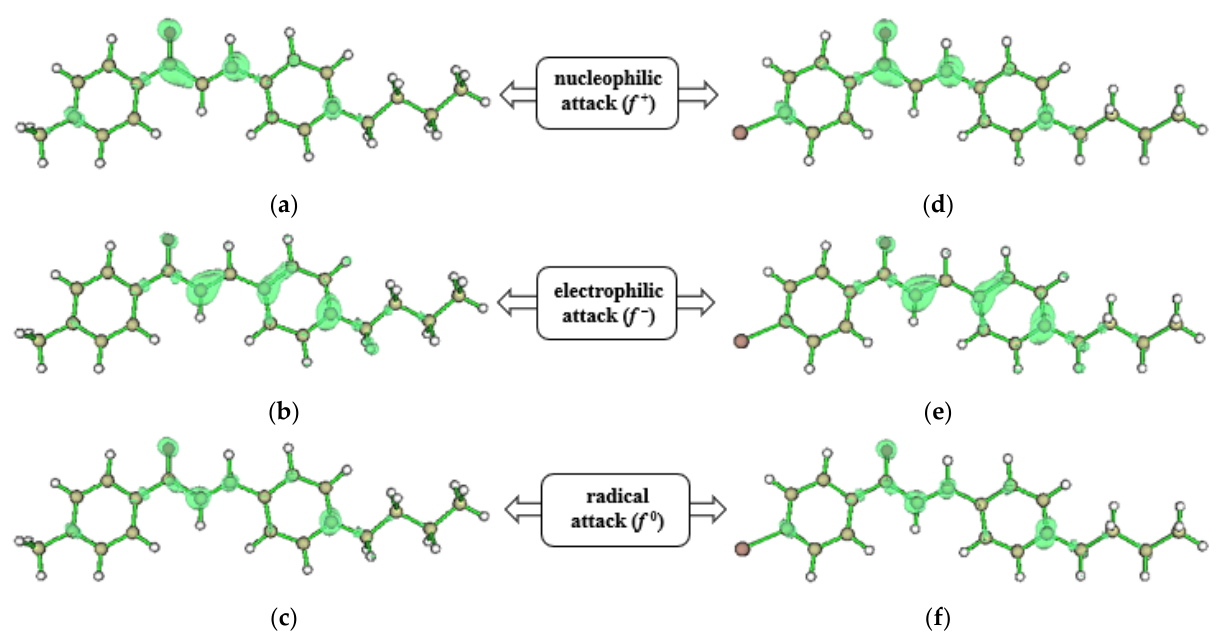
Figure 6. Isosurfaces of the ( a , d ) f^+, ( b , e ) f^ − , and ( c , f ) f^0 functions indicating the nucleophilic, electrophilic, and radical attack regions, respectively, for BMP and BBP molecules, calculated at value of 0.5.